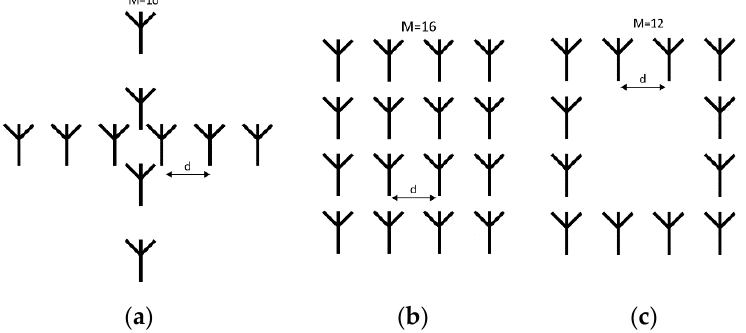
Figure 3. ( a – c ) Typical uniform rectangular array (URA) configurations.